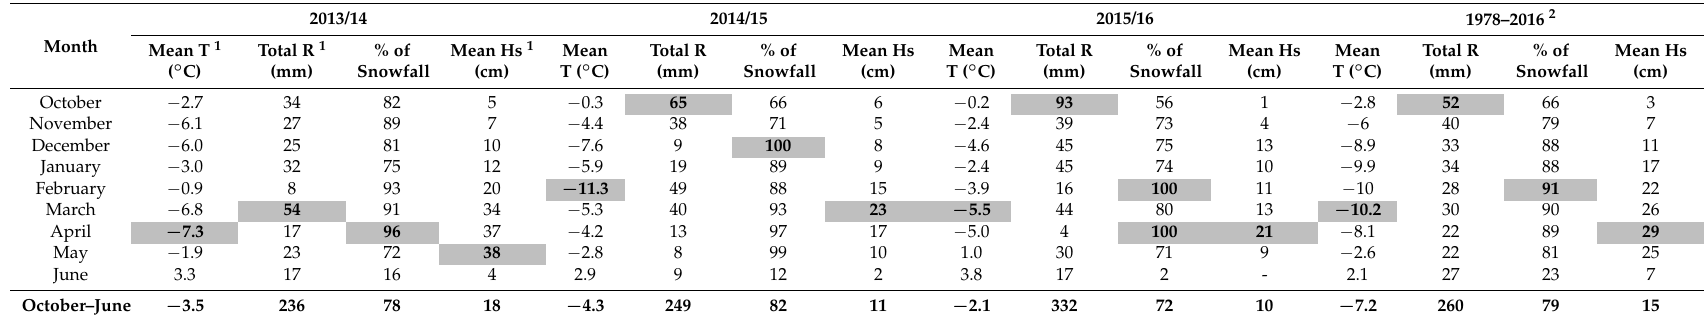
Table 1. Meteorological data from PPS in the snow seasons 2013/14, 2014/15 and 2015/2016. Extreme values are highlighted. Percentage of snowfall (snow pellets included) in the total precipitation sum calculated from event